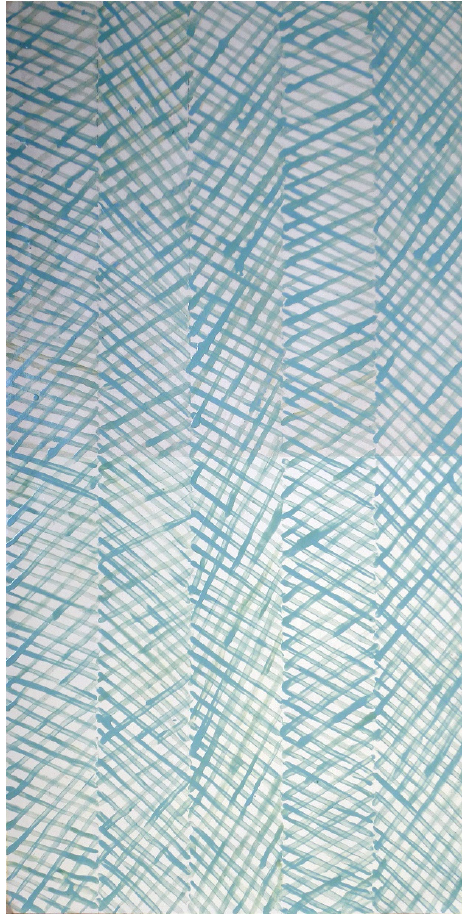
Figure 24. Albert. Glass with Sour Cream (N. Stolpovskaya). 1980. Paper, alkyd enamel. 84 cm × 42 cm. Courtesy of the